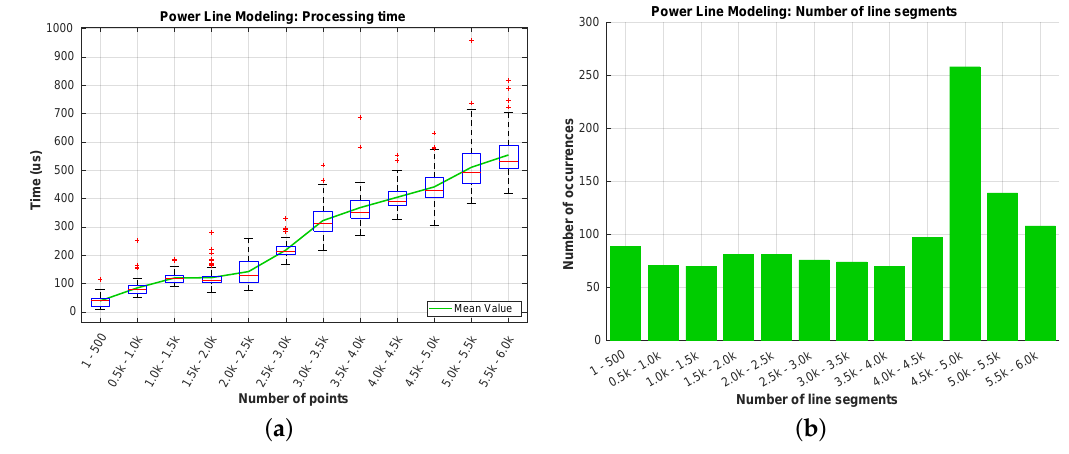
Figure 22. Processing time ( a ) and number of line segments ( b ) for power line modeling.